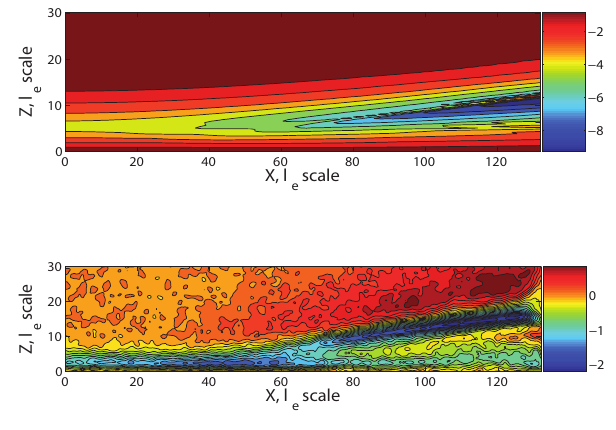
Fig. 6. Distribution of electric field E z in XZ plane: analytical model (top) and PIC simulation (bottom).